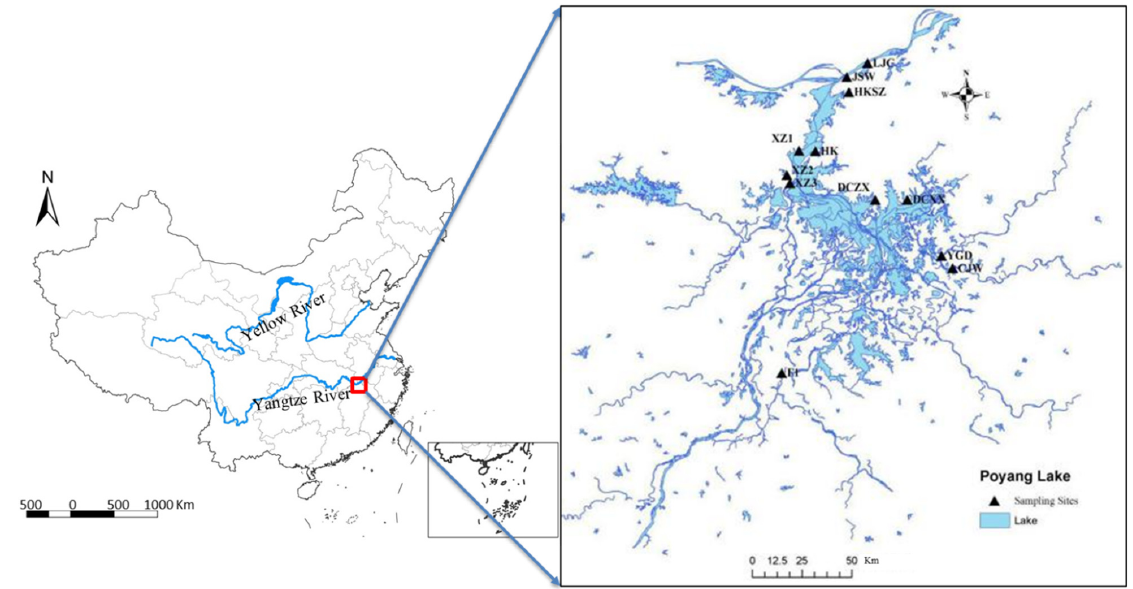
Figure 1. A map depicting the location of the study area in China (left plate) and an extended map of the area showing the Poyang Lake and the sampling sites in the lake region. Note: DCZX = Huaqiao village in Zhouxi Town in Duchang County; DCXX = Jingtou village in Tunxi Town in Duchang County; XZ1 = Xingzi Observatory; XZ2 = Yanhuachi village in Weinan Town in Xingzi County; XZ3 = Xixi Street in Xi village in Weinan Town in Xingzi County; HK = Hukou CJW in Caijiawan County; YGD = Yaogongdu; F1 = Shatan Bridge; JSW = Jinshawan Industrial Park; LJC = Liaojiachang; HKSZ = Shuangzhong Town, Hukou.